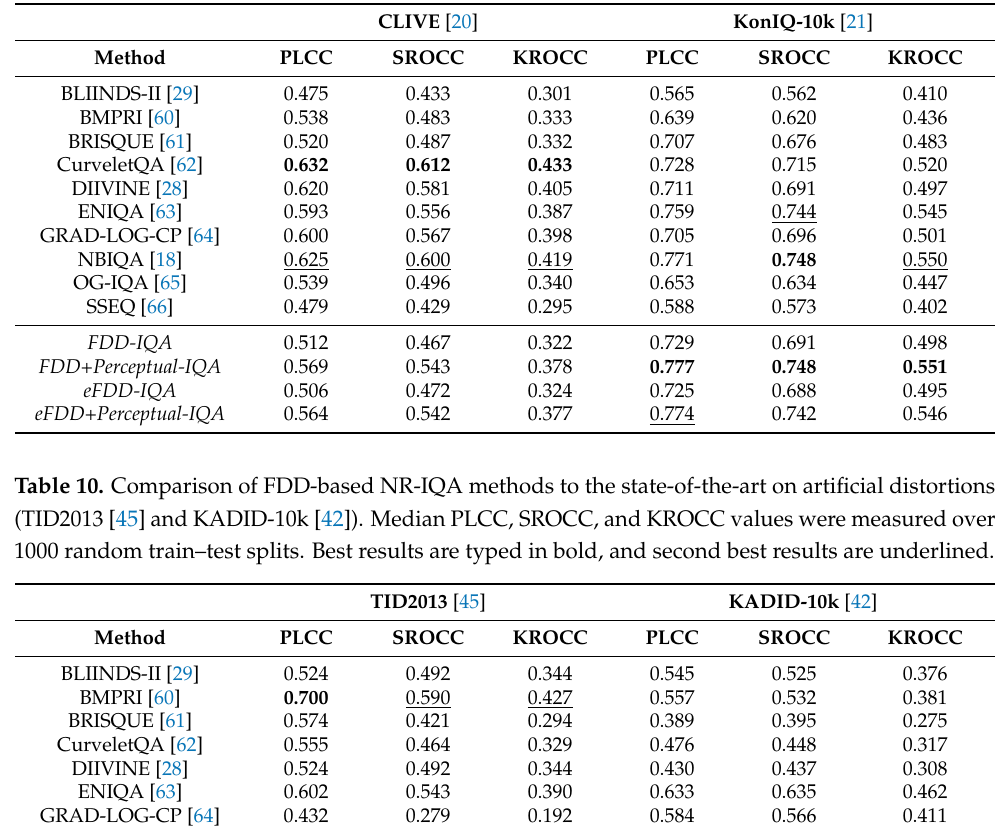
Table 9. Comparison of FDD-based NR-IQA methods to the state-of-the-art on authentic distortions (CLIVE [20] and KonIQ-10k [21]). Median PLCC, SROCC, and KROCC values were measured over 1000 random train–test splits. Best results are typed in bold, and second best results are underlined.